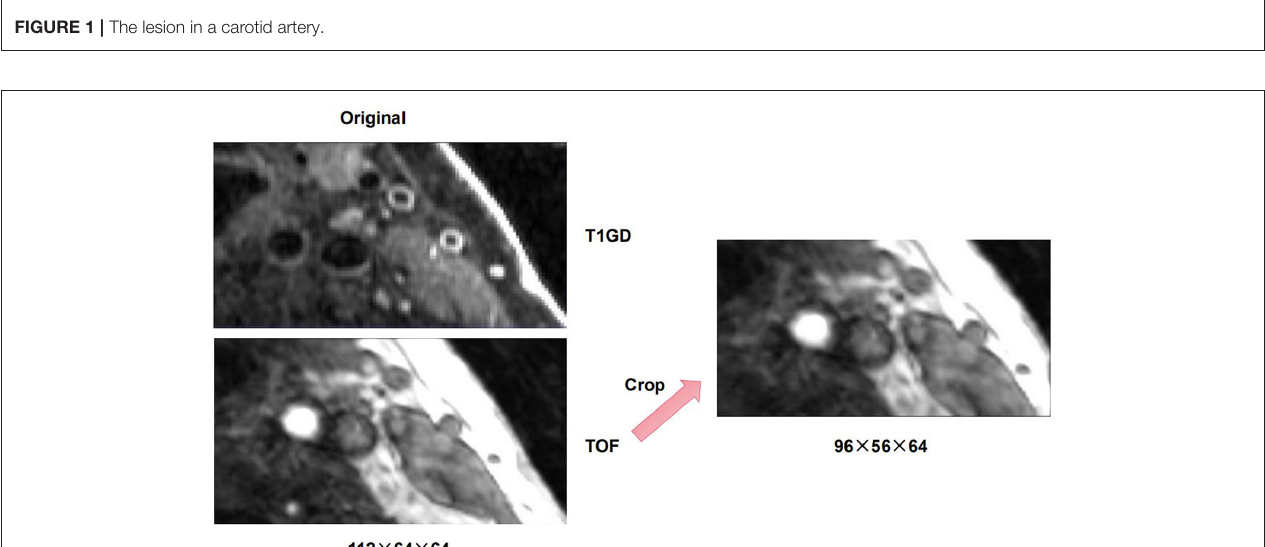
FIGURE 2 | An example of cropped carotid artery MR sequences.